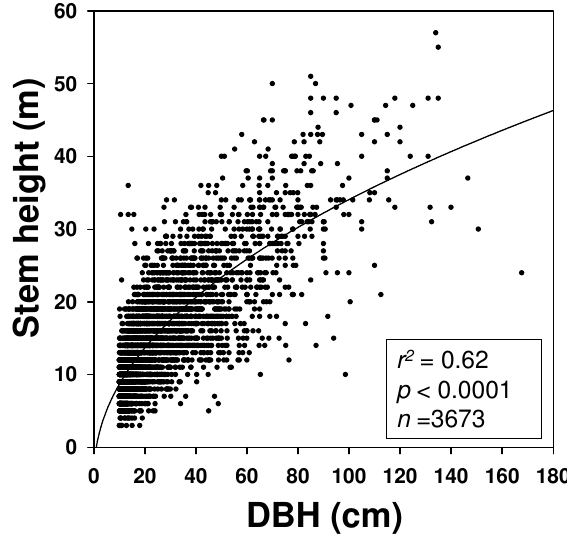
Fig. 4. The relationship between diameter (DBH, cm) and height (m) for 3673 trees measured in 1989 is